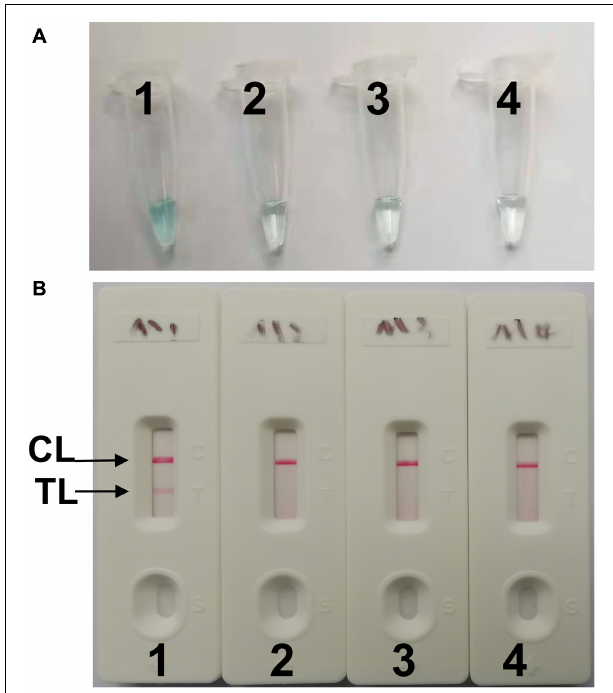
FIGURE 2 | Confirming of C. tropicalis -MCDA products. (A) The C. tropicalis -MCDA amplification products were analyzed with MG reagents through visually observation of the color change. (B) Lateral flow biosensor (LFB) was applied for visual detection of C. tropicaliss -MCDA products, two lines contained test line (TL) and the control line (CL) appeared in positive samples, but only the CL observed in negative samples. Tube 1/Biosensor 1: positive amplification of C. tropicalis (ATCC13803); Tube 2/Biosensor 2: negative amplification of C. albicans (ATCC10231); 3: negative amplification of Klebsiella pneumoniae ; Tube 4/Biosensor 4: blank control